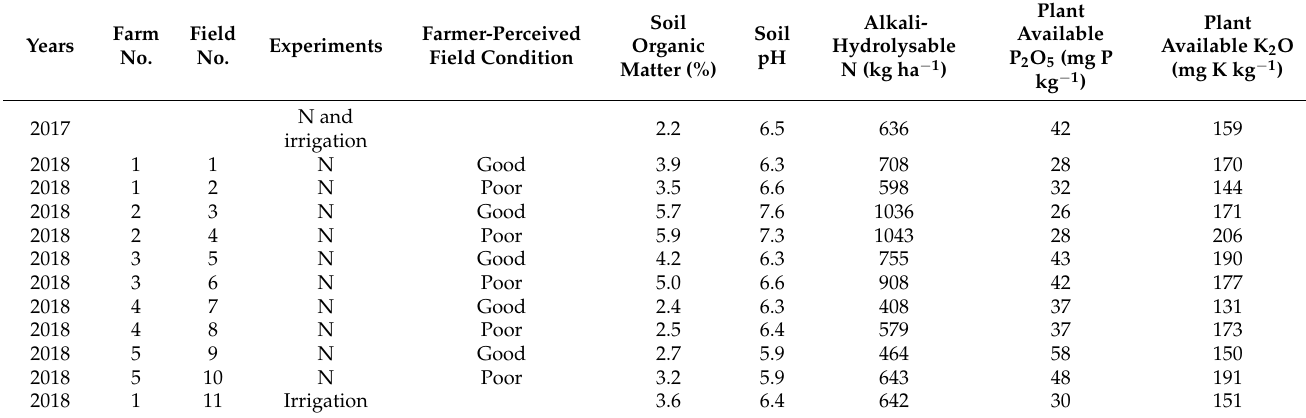
Table 2. The soil testing results for the experimental field in 2017, for 10 nitrogen (N) experimental fields in five farms (Field 1-10 in Farm 1-5) in 2018; and for one irrigation experimental field (Field 11 in Farm 1) in 2018. In both years, the soil samples were collected in spring after ploughing and before planting until a depth of 30 cm. The “farmer perceived good/poor condition fields” were selected by farmers, based on yield performance of previous years. Farm Years